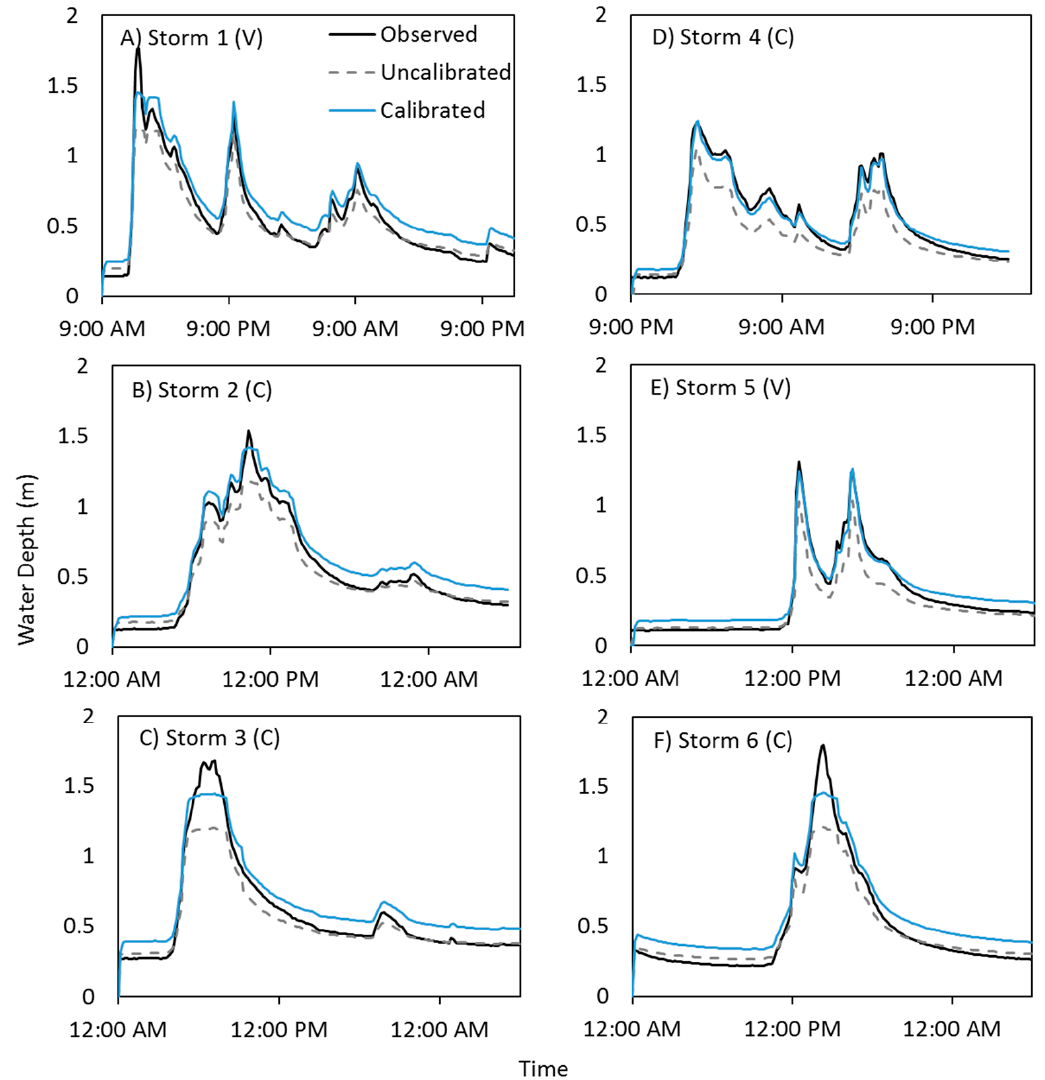
Figure 4. Observed water depth, uncalibrated, and final calibrated model simulations for ( A ) Storm 1 (28 Nov 2019), ( B ) Storm 2 (4 Dec 2019), ( C ) Storm 3 (26 Dec 2019), ( D ) Storm 4 (29 Jan 2021), ( E ) Storm 5 (3 Mar 2021), and ( F ) Storm 6 (14 Dec 2021). Where C and V denote calibration and validation, respectively.